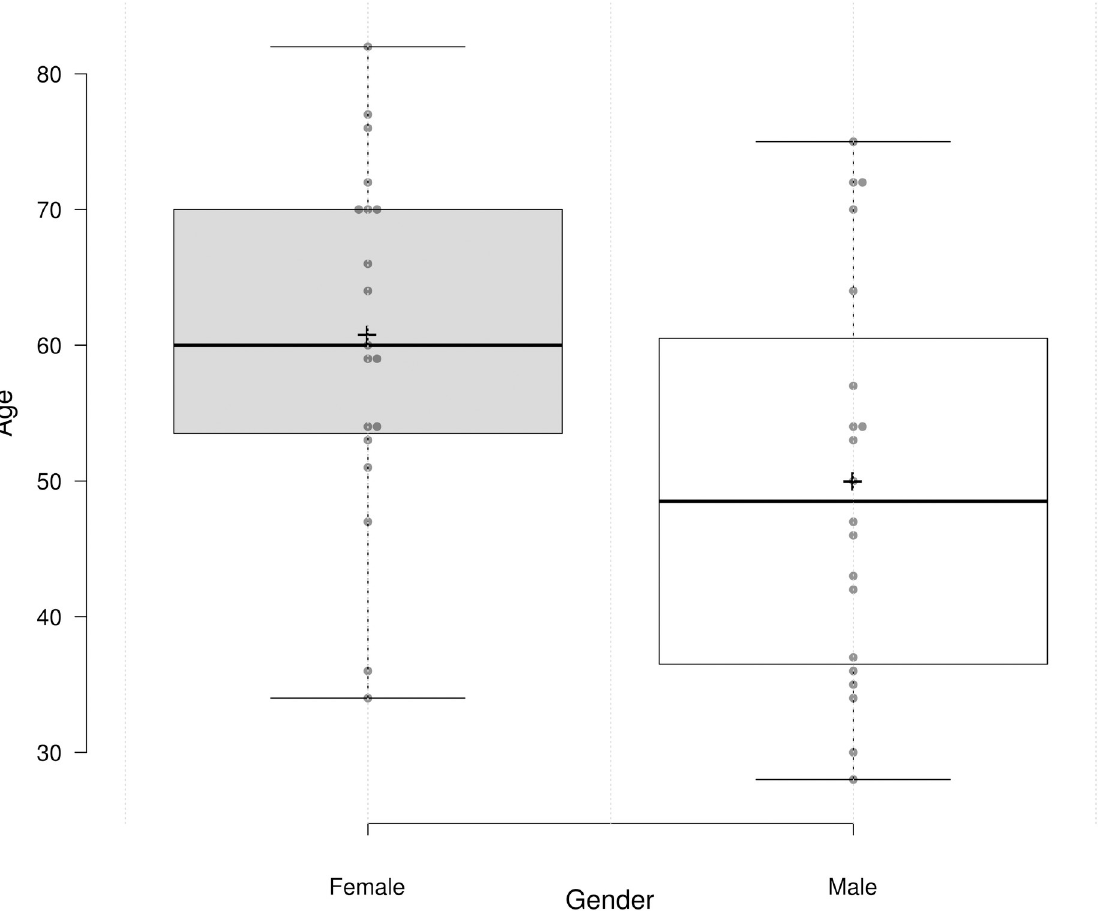
Fig 9. Age and gender distribution among COVID-19